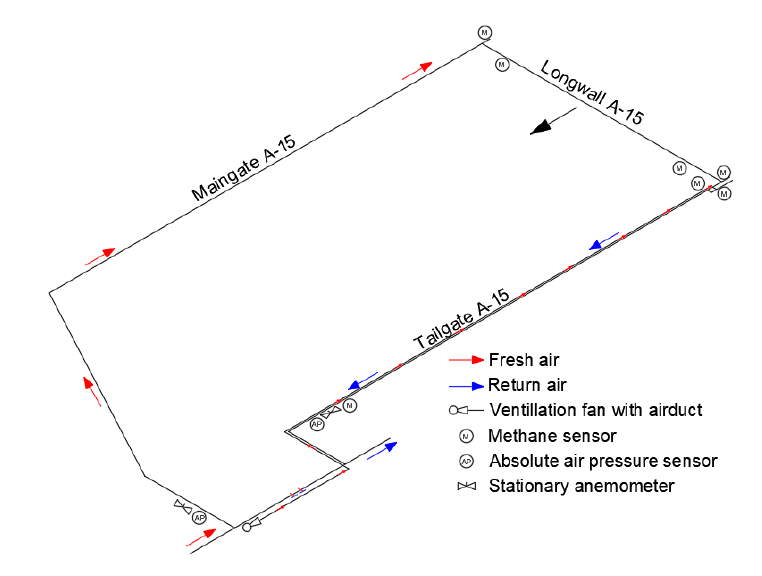
Figure 2. Diagram of selected for testing longwall area (own